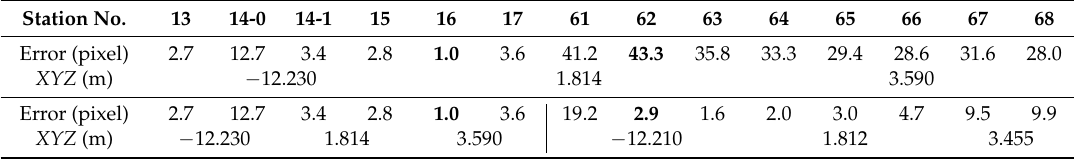
Table 4. Reprojection error after forward intersection with the exposure